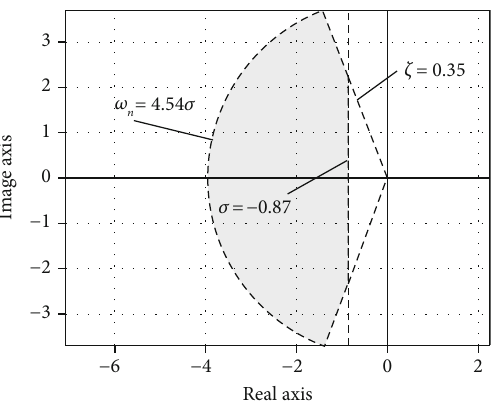
Figure 2: General stability target domain satisfying FQ